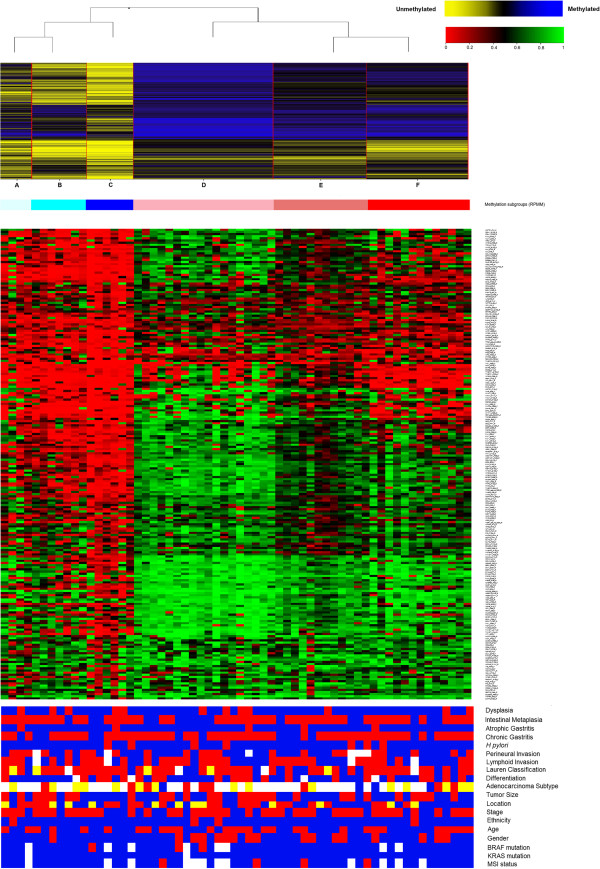
Cluster diagram of 219 tumor-specific CpG sites (rows) in 60 GC tumor samples (columns). The RPMM tree and clusters (labelled A-F) under the two major subtypes (A-C and D-F) are shown at the top of the Figure. Clinicopathological and molecular features are shown below the cluster diagram. White rectangles are cases with missing data. History of dysplasia: yes (red), no (blue); History of intestinal metaplasia: yes (red), no (blue); History of atrophic gastritis: yes (red), no (blue); History of chronic gastritis: yes (red), no (blue); H. pylori status: yes (red), no (blue); Perineural invasion: yes (red), no (blue); Lymphoid invasion: yes (red), no (blue); Lauren classification: diffuse (blue), intestinal (red), mixed (yellow); Differentiation: poor (blue), moderate (red); Adenocarcinoma subtype: mucinous (blue), signet ring (red), tubular (yellow); Tumor size: >4.5 cm (median) (red), ≤4.5 cm (blue); Location: distal 1/3 (blue), middle 1/3 (red), proximal 1/3 (yellow); Stage: III/IV (red), I/II (blue); Ethnicity: Non-Chinese (red), Chinese (blue); Age: >71 years (median) (red), ≤71 years (blue); Gender: female (red), male (blue); BRAF mutation: mutant (red), wildtype (blue); KRAS mutation: mutant (red), wildtype (blue); MSI status: MSI (red), MSS (blue).